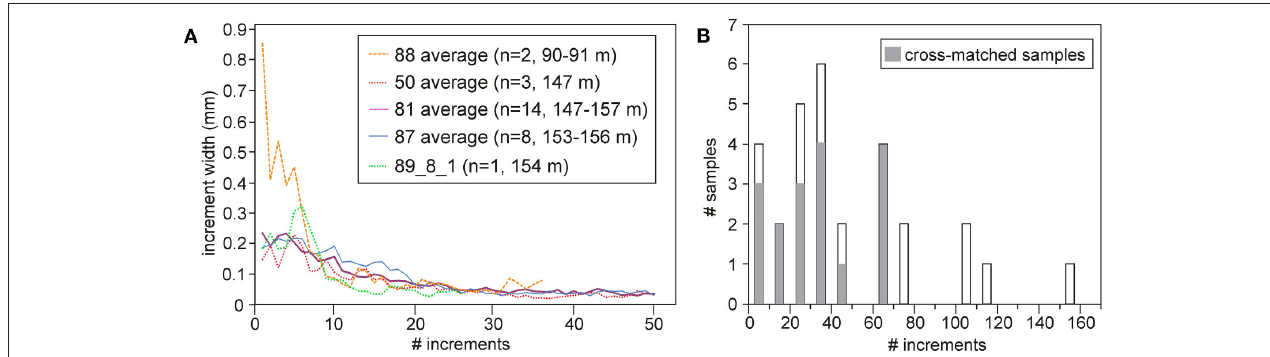
FIGURE 3 | (A) Ontogenetic growth curves of Madeiran G. vangentsumi shells averaged by collection sites. Group 88 was collected at a depth of 90m, while the other groups (50, 81, 87) were collected at depths between 147 and 157m. (B) Age distribution of the 29 analyzed shells in ten-year clusters: gray filling represent successfully cross-dated